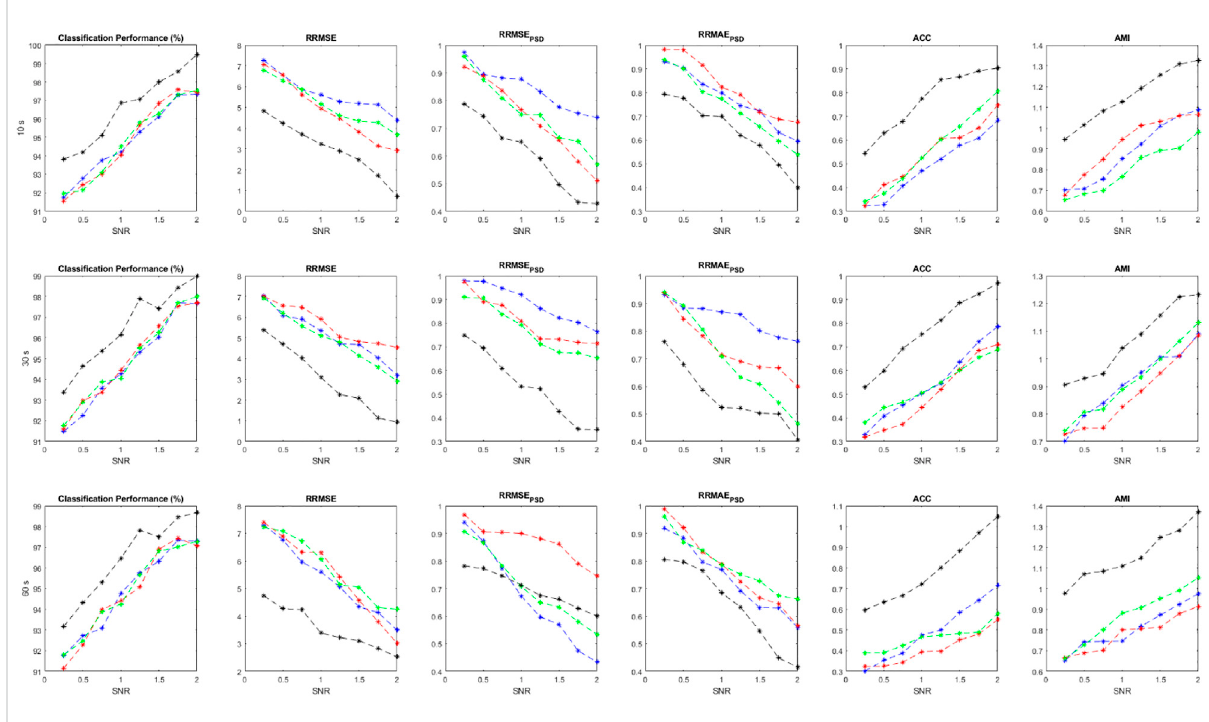
FIGURE 7 Performance measures for SSCEEG2 using evaluation criteria including ACP , RRMSE , RRMSE PSD , RRMAE PSD , ACC , and AMI